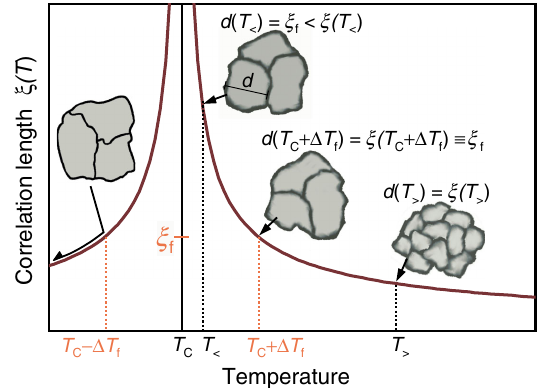
FIG. 3. Domain formation and the Kibble-Zurek mechanism. , fluctuating regions of lateral extension d occur with Above T C uniform orientation of the emerging order parameter (fuzzy þ (cid:2) T ), the size of patches). At high temperature ( T > > T C f the correlated regions is determined by the correlation length ¼ T þ (cid:2) T , a freeze-out of (purple curve). At temperature T f C f the lateral extension d begins, and below the freeze-out tem- perature, the lateral extension of the fluctuating regions can no longer match the diverging correlation length. The size of þ (cid:2) T is set the fluctuating regions at temperatures T < < T C f by the correlation length at the freeze-out temperature, (cid:3) f ¼ (cid:3) ð T þ (cid:2) T Þ , and corresponds to the ‘‘communication length,’’ C f which is the distance that information propagates during the time þ (cid:2) T (cid:2) (cid:2) T to T (red in which the system cools from T C f C f (cid:2) (cid:2) T , stable domains of lateral ex- vertical lines). Below T C f þ (cid:2) T Þ form (indicated by solid black domain tension (cid:3) ð T C f